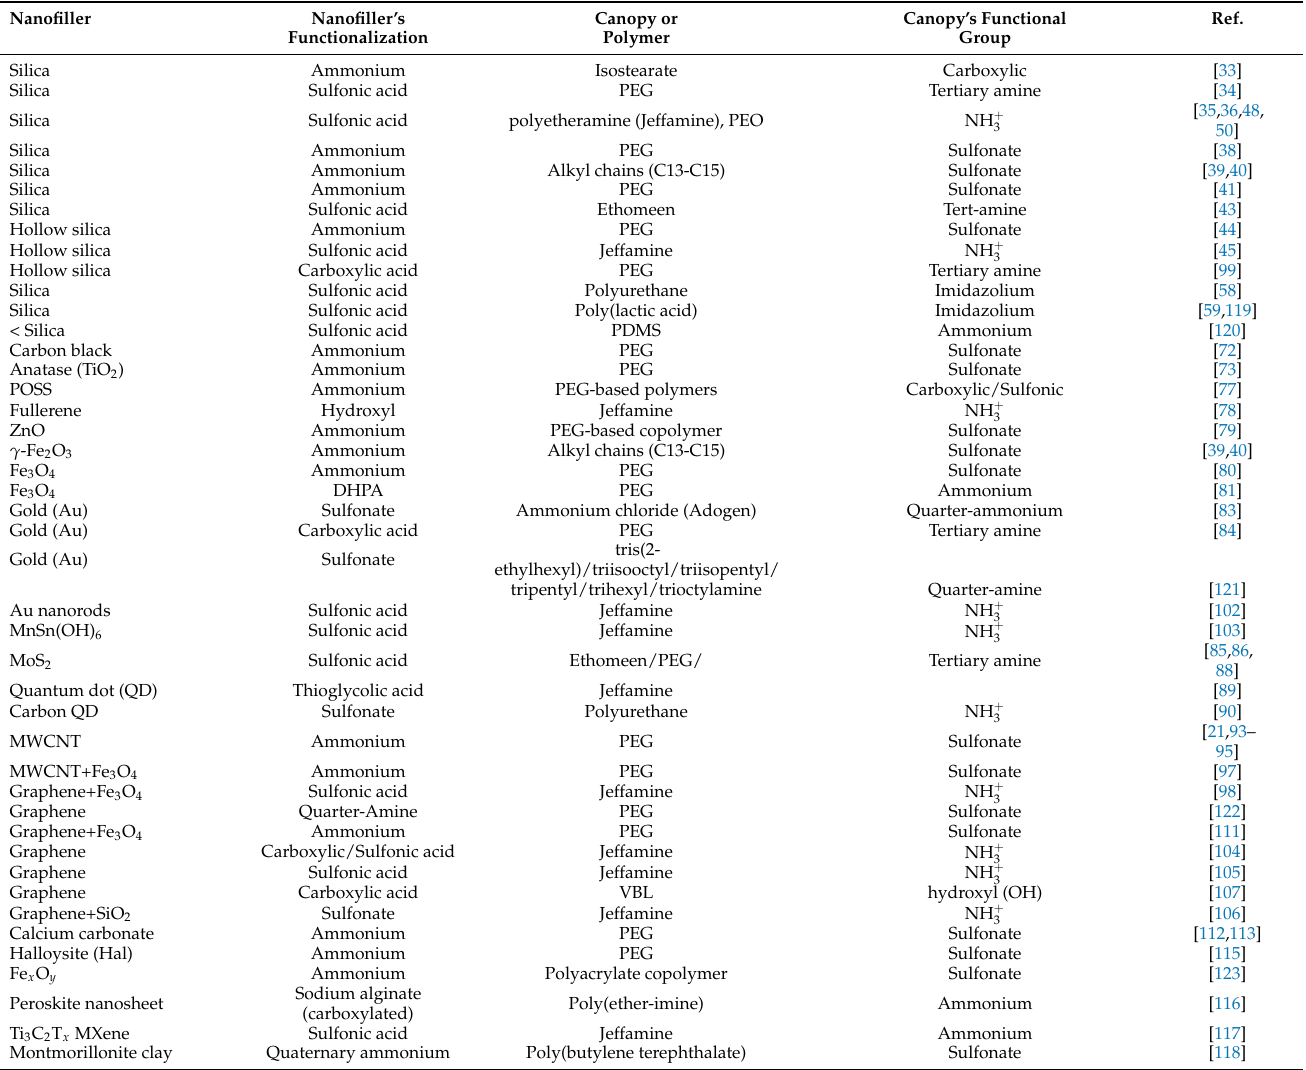
Table 1. Ionic nanoparticle organic hybrids and ionic